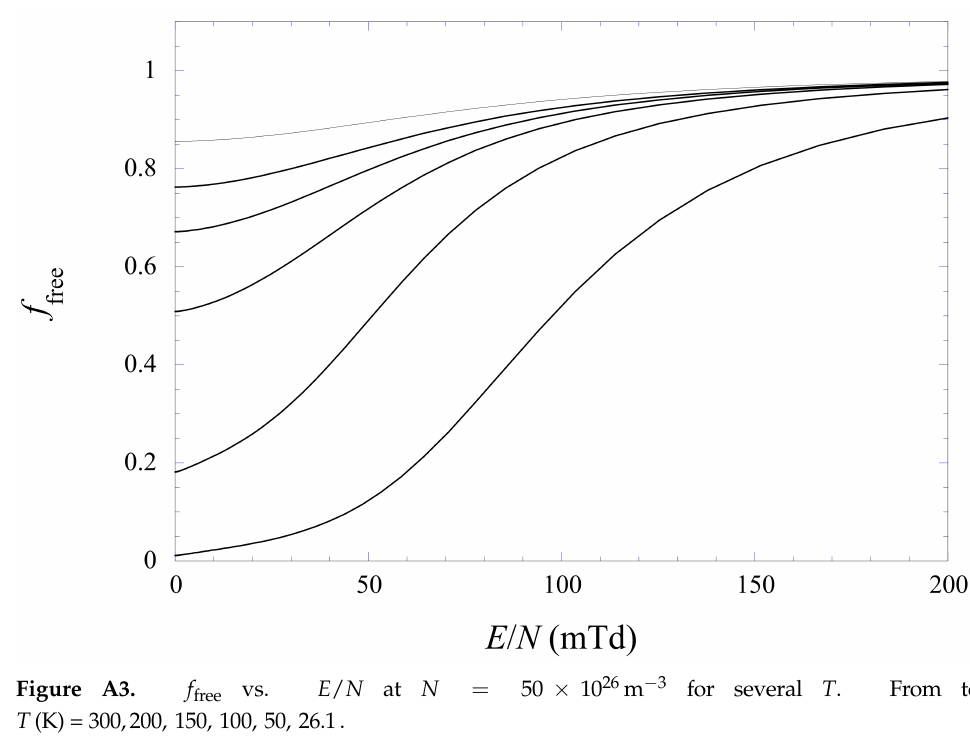
10 26 m − 3 for several T . From top: ×